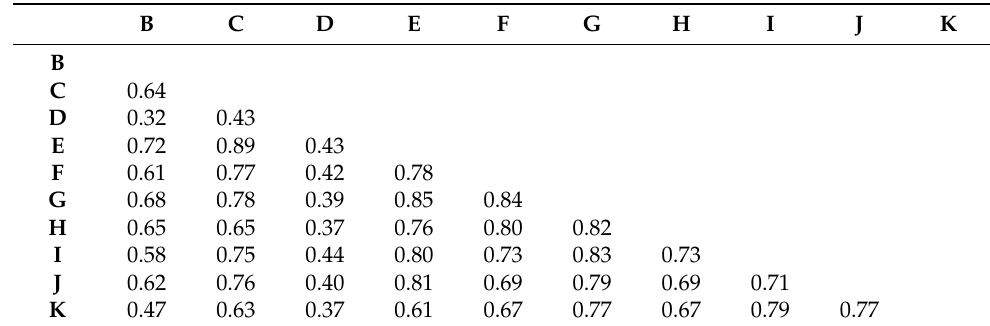
Table 7. Correlations among 10 attributes of 10IBLP-I.